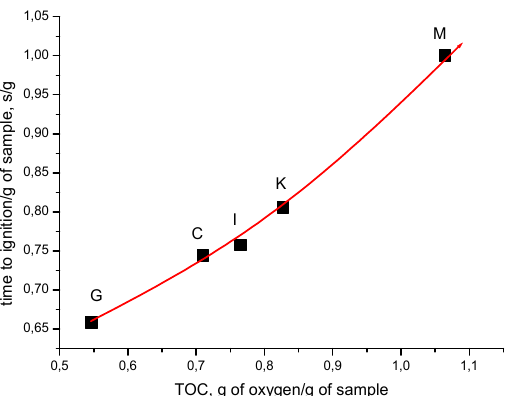
Figure 8. Correlation between time to ignition and the total oxygen consumed (TOC) related both to the initial mass of the sample for C—Cumaru, G—Garapa, I—Ipe, K—Kempas, M—Merbau.